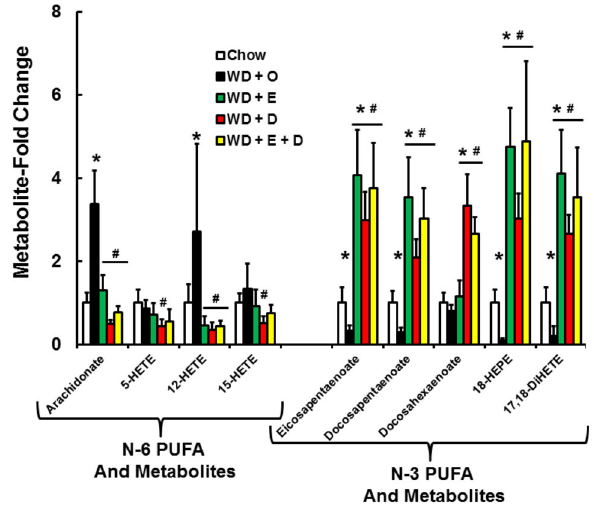
Figure 15. Diet effects on hepatic oxidized lipids. N-6 and n-3 PUFA and oxidized fatty acids were quantified by the metabolomic analysis (Methods). Results are expressed and Metabolite-Fold Change relative to the chow-fed group, mean ± SD, n=8/group; *, p ≤ 0.05 versus chow; #, p ≤ 0.05 versus WD + O. doi: 10.1371/journal.pone.0083756.g015 epoxide hydrolases (EPHX1 & 2) (Figure 16 ). Expression of